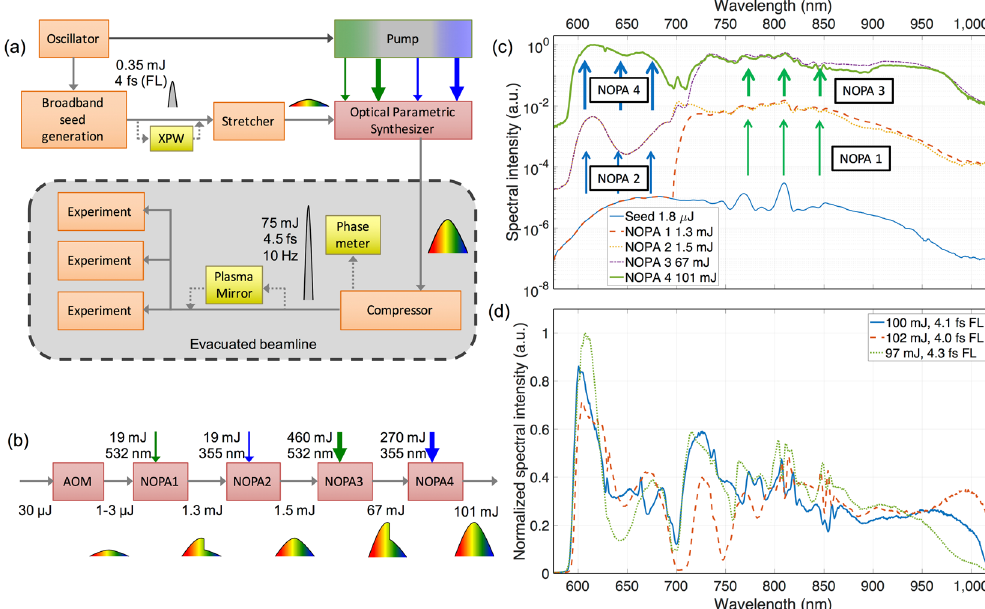
Figure 1. Working principles of the LWS-20 relativistic sub-two-cycle system. ( a ) Schematic of the light source. Pulses coming from a common broadband Ti:Sa oscillator are divided into a seed and a pump arm. The seed is generated by first amplifying the oscillator pulses in a 9-pass CPA system and then broadening them in a neon-filled HCF. After broadening, an XPW setup is optionally used for temporal contrast enhancement. The seed is then stretched in a grism stretcher and afterwards sent into the OPS. The pump for the four NOPA stages is generated in a Nd:YAG laser amplifier, providing a low-energy and a high-energy arm at both the second harmonic (532 nm) and the third harmonic (355 nm). After the OPS, the pulses are compressed and sent to the experimental chambers. A single-shot CEP meter is optionally used for electric-field-sensitive experiments. ( b ) Schematic of the OPS, depicting the temporal evolution of the pulses at the different amplification stages. The AOM first shapes the spectral amplitude and phase of the seed pulses which are then fed into the four NOPA stages. The first two NOPA stages are pumped by the two low-energy pump beams at 532 nm and 355 nm, respectively, and the latter two are pumped by the two high-energy pump beams. ( c ) Spectral intensity evolution in the synthesizer. Optical spectrum of seed (blue line), and after the first (orange dashed line), second (yellow dotted line), third (purple dash-dotted line), and fourth (green thick line) amplification stage. Consecutive energy enhancements in the visible and near-infrared parts of the seed provide a broadband spectrum beyond what is achievable in a single stage. ( d ) Spectral intensity after amplification, but before compression, for different configuration of the NOPA stages depicting the tuning capabilities of the OPS. The corresponding Fourier-limited pulse durations are indicated in the